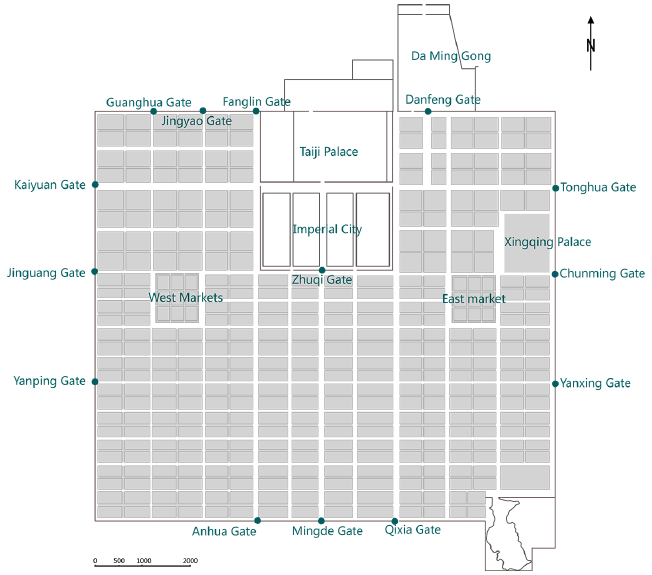
Figure 1. Recovery plan of Chang’an of the Tang Dynasty. Drawing by the author based on Liu Dunzhen: The History of Ancient Chinese Architecture. China Architecture and Building Press, 2008, p. 118.